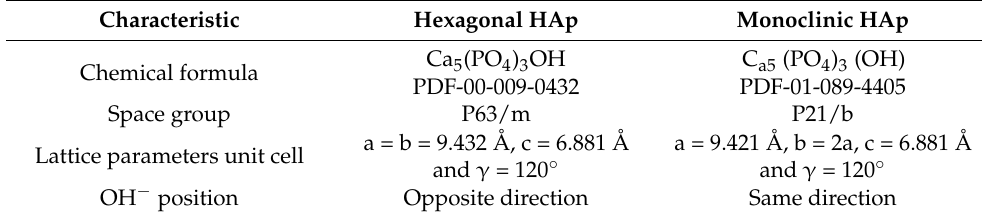
Table 1. Comparison between hydroxyapatite (Hap) phases [25–28].